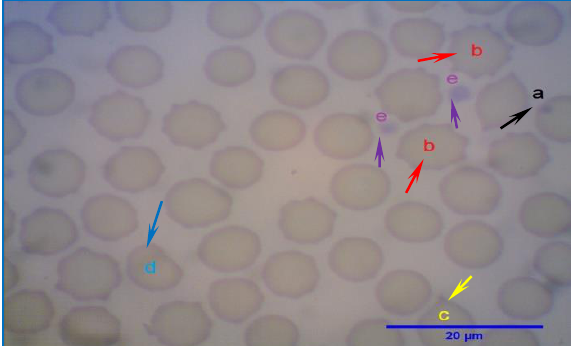
Figure, 2: (a) Howel-Jolly body. (b) Echinocyte shape of RBC. (c) Tear drop shape RBC. (d) Helmet shape RBC. (e) Blood Platelets (100x × 1.3 megapixels).